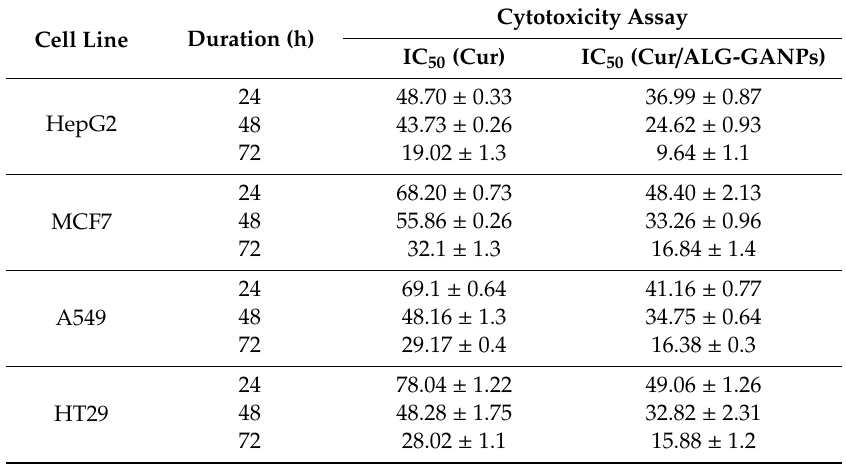
Table 2. The IC 50 values for HepG2, MCF7, A549 and HT29 cells generated from MTT assay following exposure to Cur and Cur / ALG-GANPs for 24, 48 and 72 h.